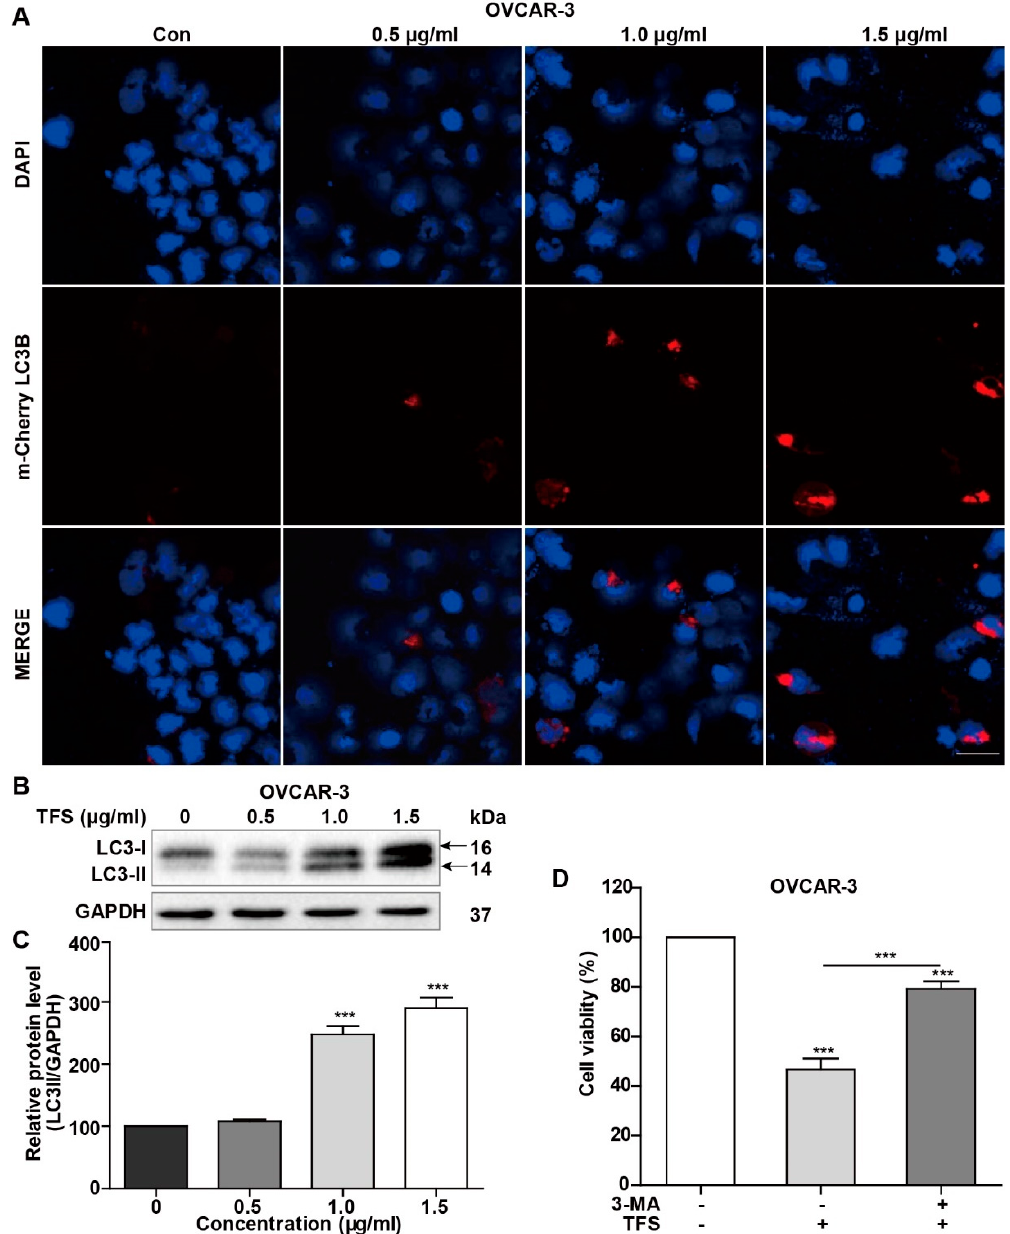
Figure 4. TFS treatment induced autophagic cell death in OVCAR-3 cells. ( A ) OVCAR-3 cells were transfected with mCherry-LC3B plasmid and treated with TFS (0, 0.5, 1.0, 1.5 µ g / mL) for 24 h. Cells